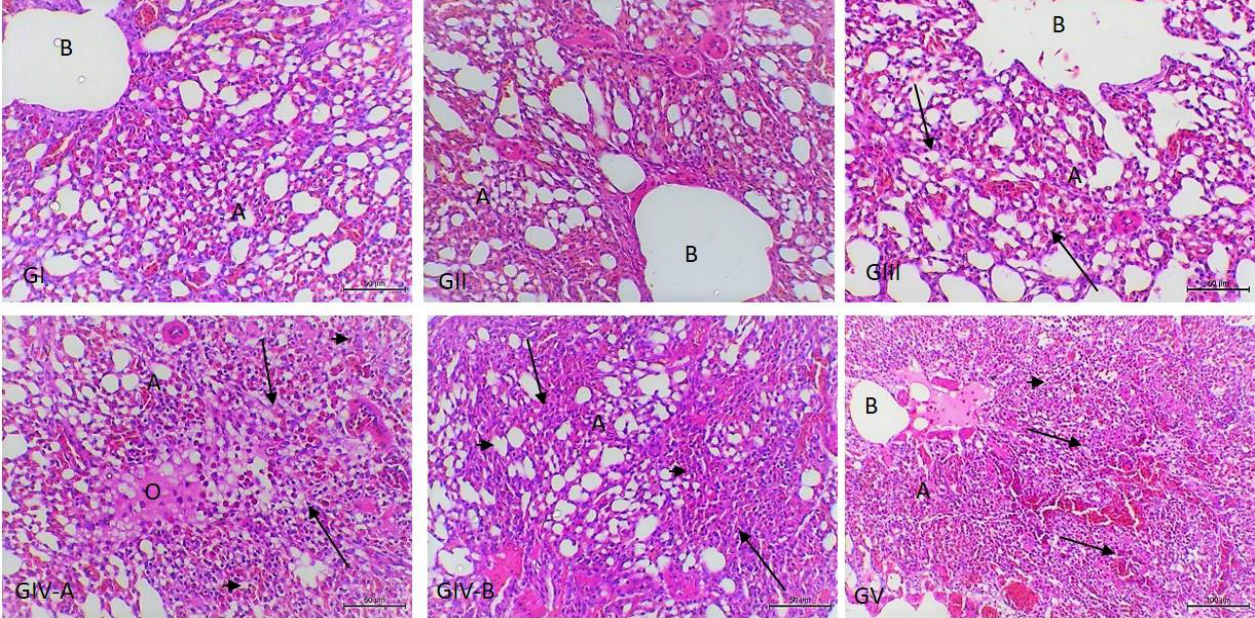
Figure 3. Photomicrograph of kidney sections from experimental groups stained with Hx & E stain. GI and GI1: kidneys show intact glomeruli ( G ) and renal tubules (T). GIII-(A and B): kidneys show slight interstitial and periglomerular mononuclear cell infiltration (arrow). GIV and GV: there was heavy interstitial and periglomerular mononuclear cell infiltration (arrow) and slight tubular baso- philia (arrowhead). The bar size of each picture is included under each picture.